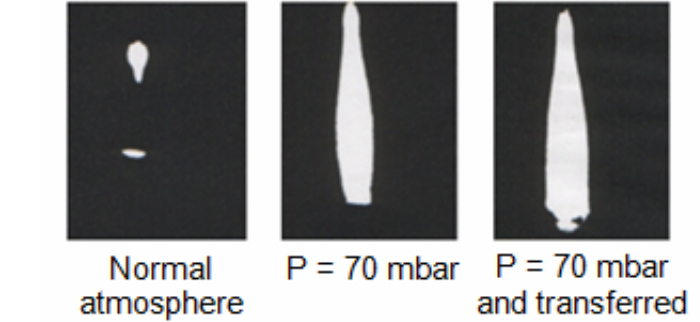
Figure 10 – Lengths of Ar / He plasma arcs for different atmospheres and transferred arc application Рис . 10 – Длина плазменной струи Ar / He прямым нагревом при различной